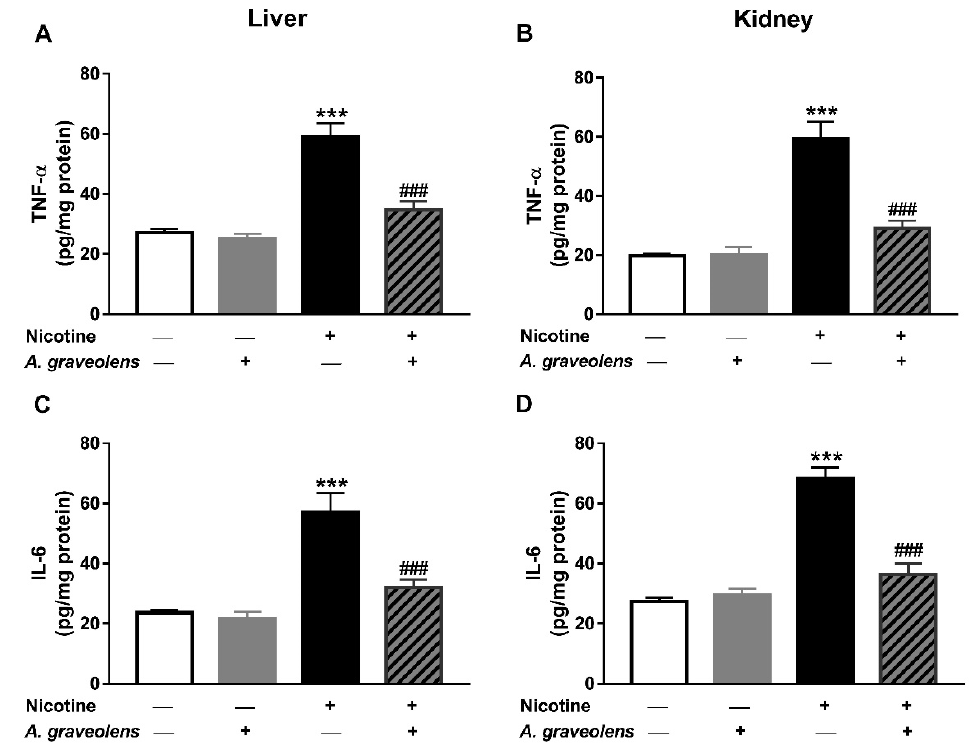
Figure 8. A. graveolens decreased TNF-α and IL-6 protein levels in liver ( A , C ) kidney ( B , D ) of nicotine-exposed mice newborns. Data are mean ± SEM, n = 8. *** p < 0.001 versus Control and ### p < 0.001 versus nicotine.